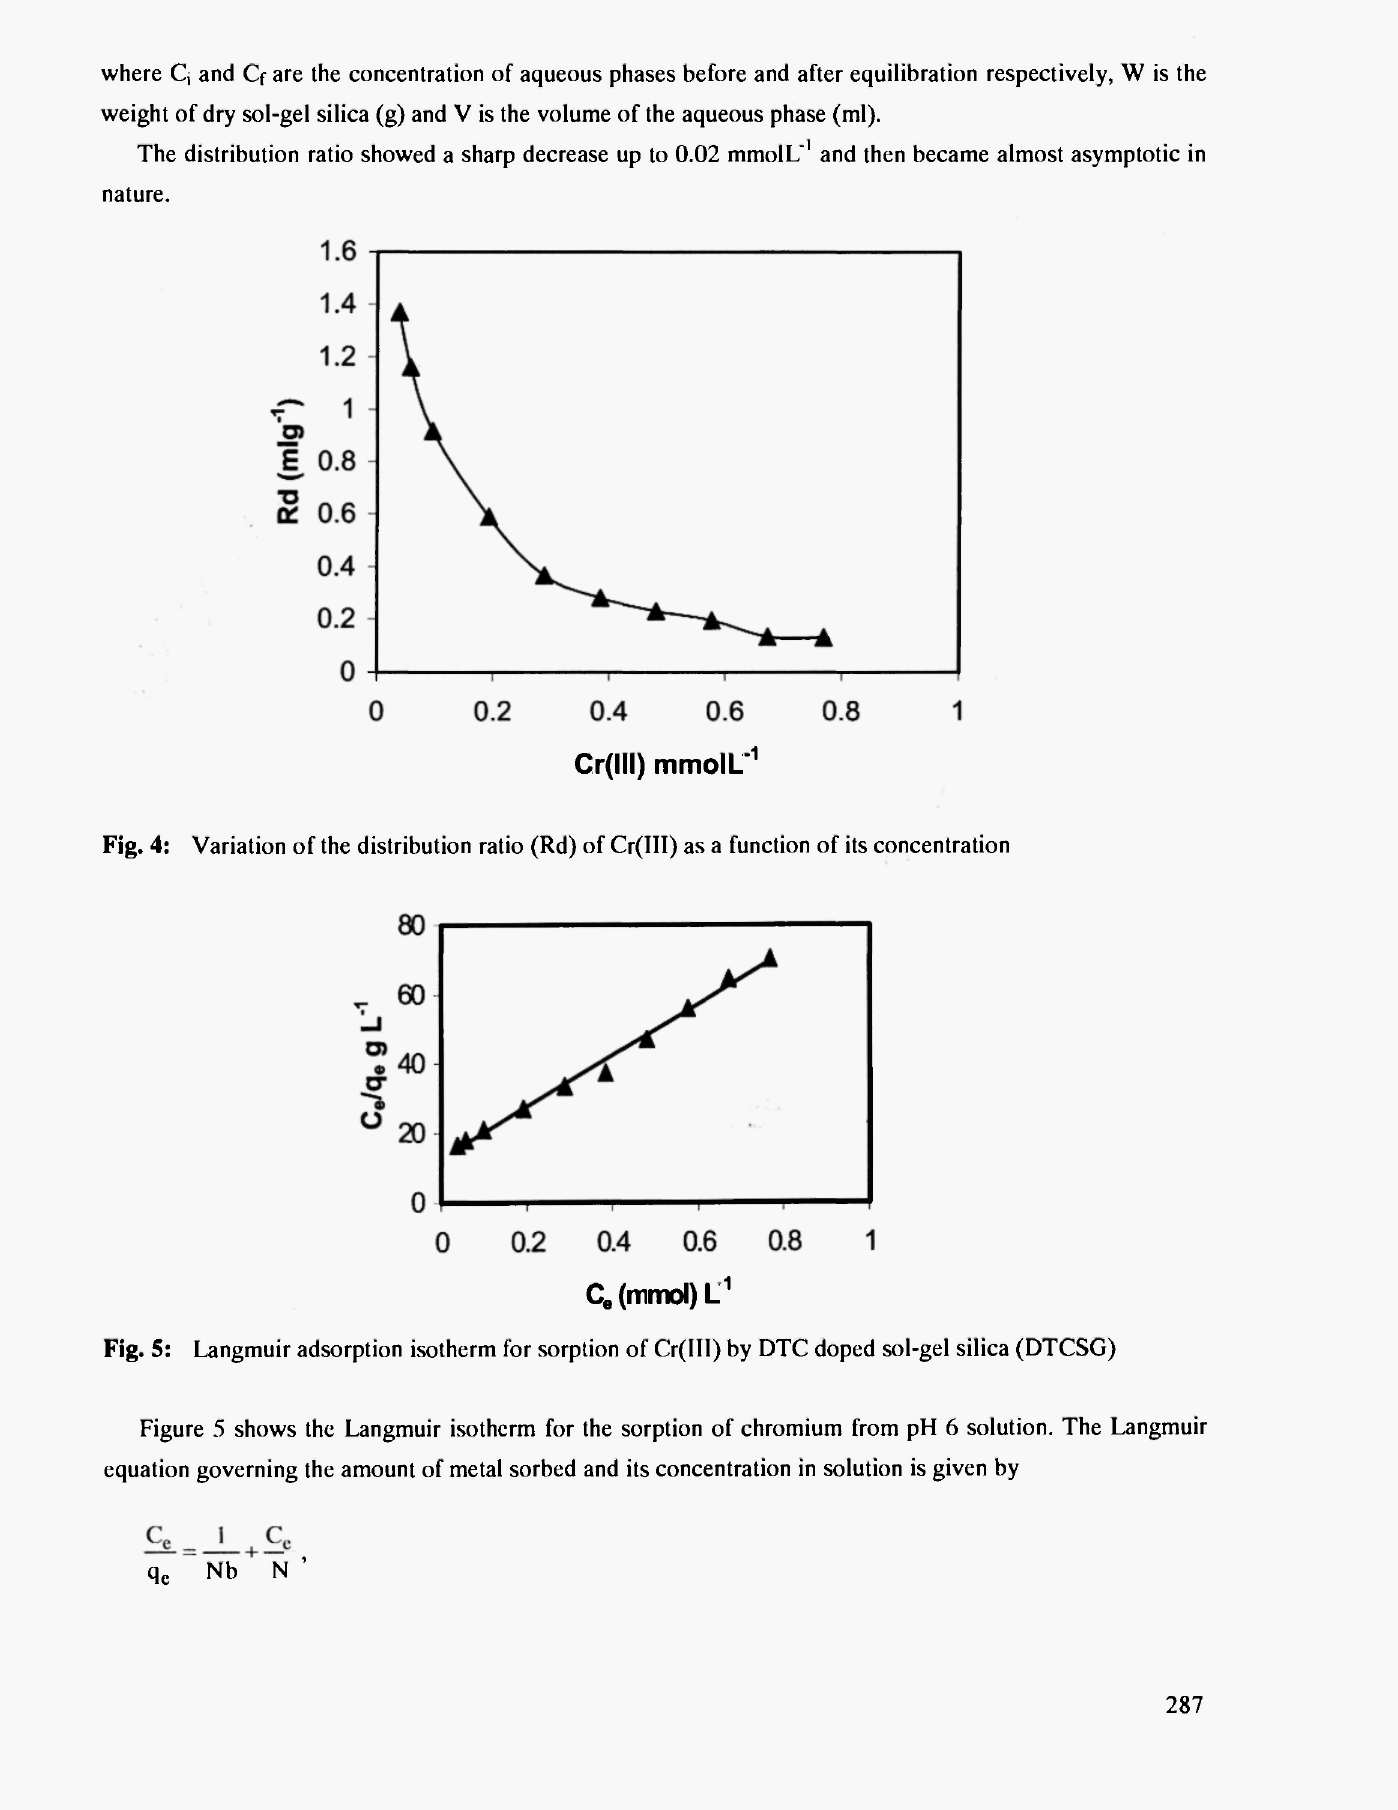
Fig. 5: Langmuir adsorption isotherm for sorption of Cr(lll) by DTC doped sol-gel silica